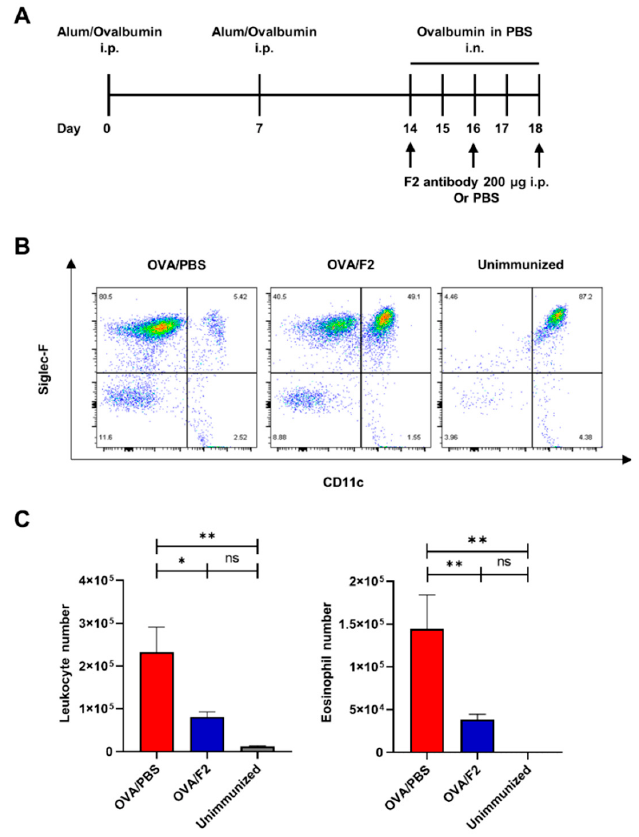
Figure 2. Administration of mAb F2 suppressed eosinophil infiltration. ( A ) The schedule of the immunization. OVA was used as the allergen emulsified with ImjectAlum for sensitization. The challenge was performed under isoflurane anesthesia by intranasal injection. Two hundred μ g mAb F2 or 200 μ L PBS was injected intraperitoneally on days 14, 16, and 18. The first injection was performed 2 h before the first intranasal challenge. ( B ) The harvested BALF was analyzed using flow cytometry. The eosinophils were defined as CD45 + Siglec-F + CD11c − . The alveolar macrophages were defined as CD45 + Siglec-F + CD11c + . The number in the corner shows the percentage of each cell population. ( C ) The total number of leukocytes and eosinophils from the BALF obtained from the control, F2-administered, and unimmunized groups of mice. The data were pooled from five independent experiments. The control ( n = 25), F2-administered ( n = 28), and unimmunized groups ( n = 15) are shown in the figure. * p < 0.05, ** p < 0.01. A p -value of less than 0.05 was considered significant.